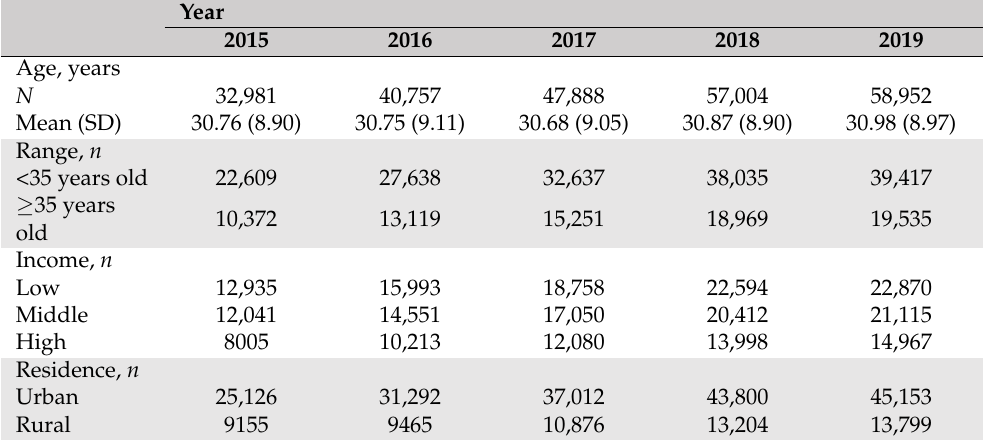
Table 1. Characteristics of women with polycystic ovarian syndrome included in this study ( n = 237,582).